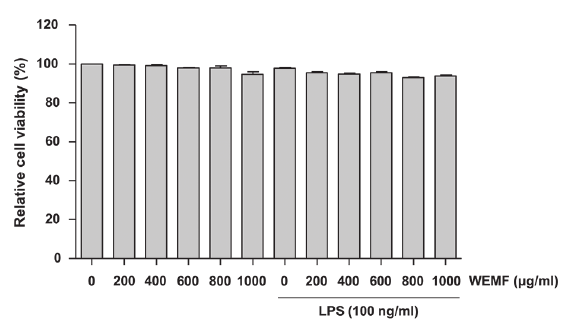
Figure 2 - Eff ects of WEMF on the cell viability of RAW 264.7 macrophages. The cells were treated with various concentrations of WEMF for 24 h or pretreated with the indicated concentrations of WEMF for 1 h prior to LPS (100 ng/ml) treatment for 24 h. Cell viability was assessed with an MTT reduction assay, and the results were expressed as the percentage of surviving cells over control cells (no addition of WEMF and LPS). Values represent the means ± SD of three independent